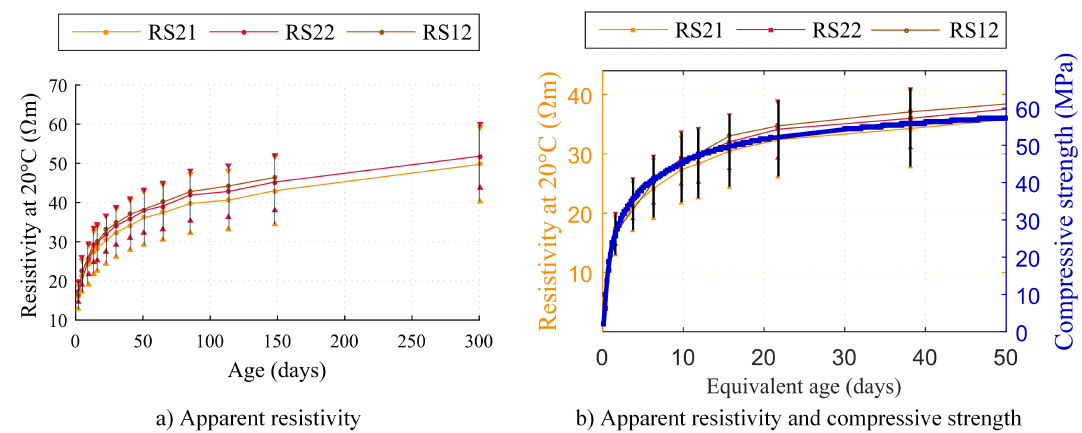
Figure 20. Evolution of the average value of the apparent resistivity computed at 20 ◦ C vs concrete age [0–300 days] ( a ) and apparent resistivity computed at 20 ◦ C vs. concrete equivalent age [0–50 days] ( b ) plotted with evolution of compressive strength. Error bars represent the standard deviation σ of